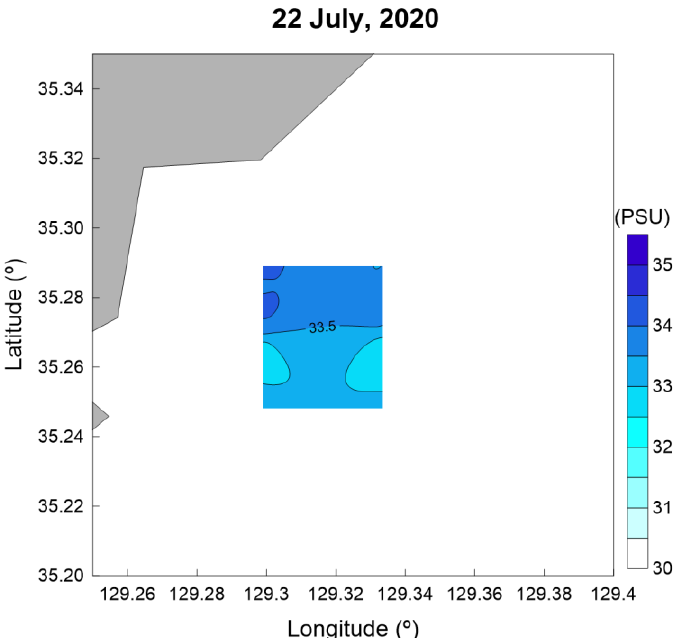
Figure 20. Distribution of salinity in the major swimming layers in the Gijang coastal waters sea (22 July, 2020).